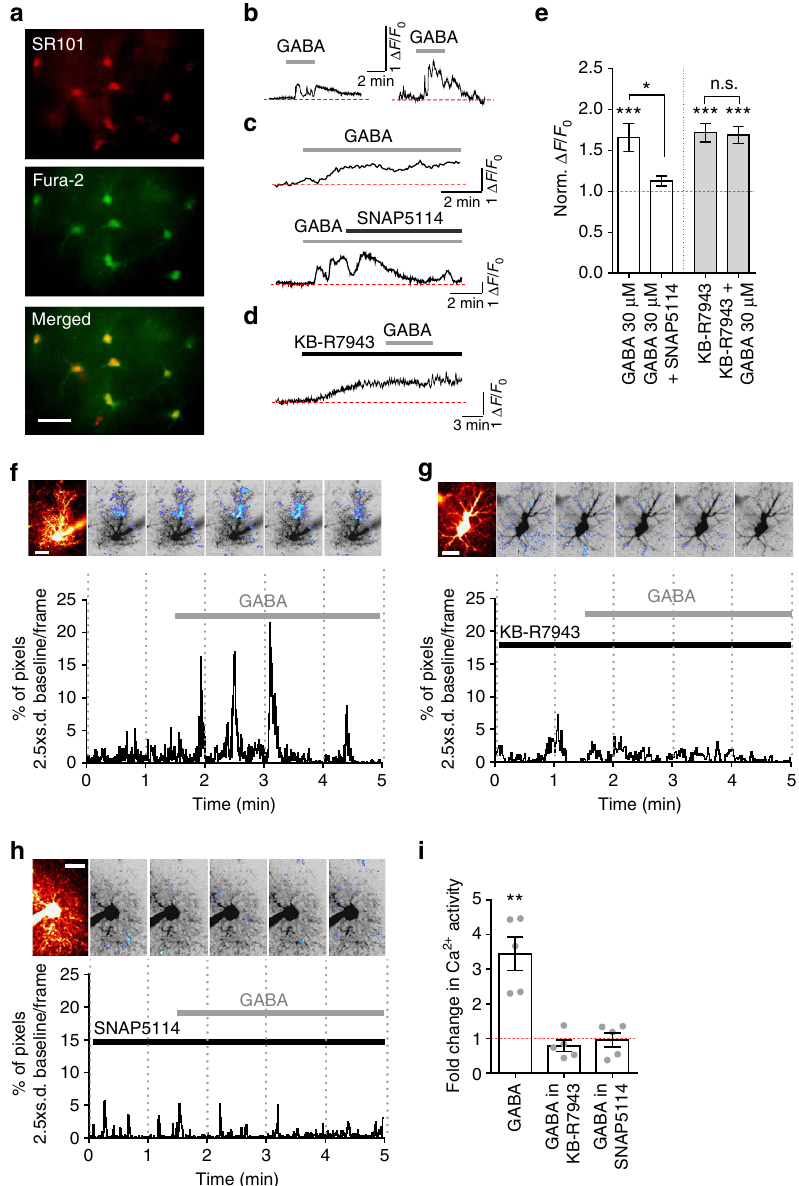
Figure 4 | GABA induces GAT-3-dependent astrocytic Ca 2 þ signalling. ( a ) Representative image of astrocytes co-loaded with the astrocytic marker SR101 and Ca 2 þ indicator Fura-2. Scale bar, 20 m m. ( b – d ) Representative traces demonstrating: 30 m M GABA-induced changes in astrocytic Ca 2 þ level ( b ); curtailment of GABA-induced increase in Ca 2 þ fluorescence by SNAP5114 ( c ); occlusion of GABA action on intracellular Ca 2 þ by 50 m M KB-R7943 ( d ). (Red dotted line—average baseline fluorescence before drug application) ( e ) Summary plot shows averaged normalized fluorescence signal reflecting the Ca 2 þ rise induced by exogenous GABA ( n ¼ 8 cells from 2 animals), its reversal by SNAP5114 ( n ¼ 8 cells from 2 animals), and the lack of response to GABA application in the presence of KB-R7943 ( n ¼ 8 cells from 2 animals). Data for GABA þ SNAP5114 and KB-R7943 þ GABA were obtained from consecutive applications of either SNAP5114 or GABA, correspondingly, in the recorded cells. ( f – h ) Ca 2 þ imaging in astrocytic processes in response to 30 m M GABA application alone ( f ) and in the presence of either 50 m M KB-R7943 ( g ), or 100 m M SNAP5114 ( h ). Patched astrocytes (Alexa 594 channel; scale bars, 20 m m) and thresholded ( þ 2.5 s.d. of the baseline) imaging raster scans (Fluo-2 MA channel) summed for each minute of recordings are shown above Ca 2 þ signalling activity traces. ( i ) Summary plot showing changes in Ca 2 þ activity in response to GABA application ( n ¼ 5 cells from 5 animals for GABA wash-on and GABA in KB-R7943; n ¼ 5 cells from 4 animals for GABA in SNAP5114). Error bars represent s.e.m.’s * P o 0.05, ** P o 0.01, *** P o 0.001 (paired t -test compared with baseline); n.s.—non-significant, paired t -test.